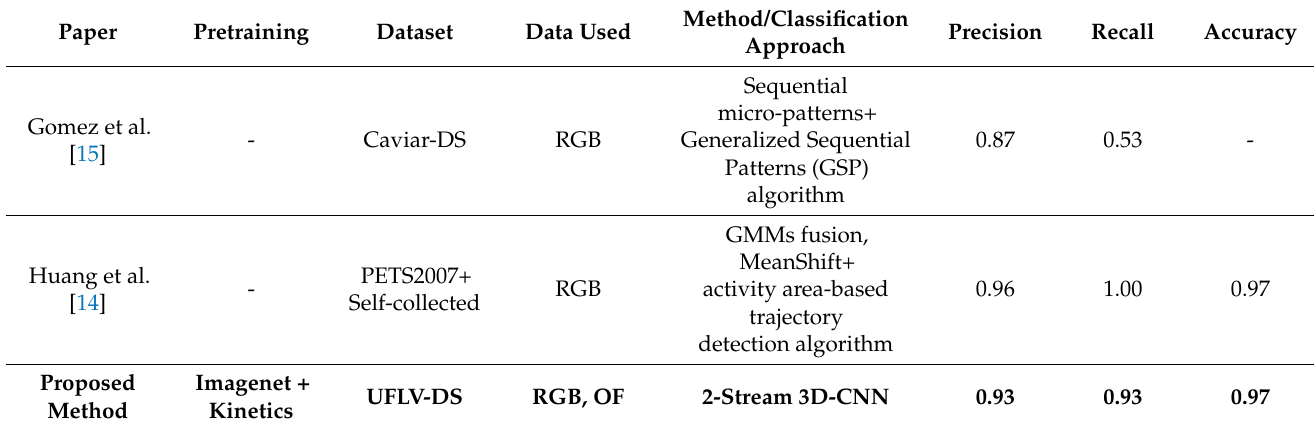
Table 9. Comparison with the state-of-the-art for